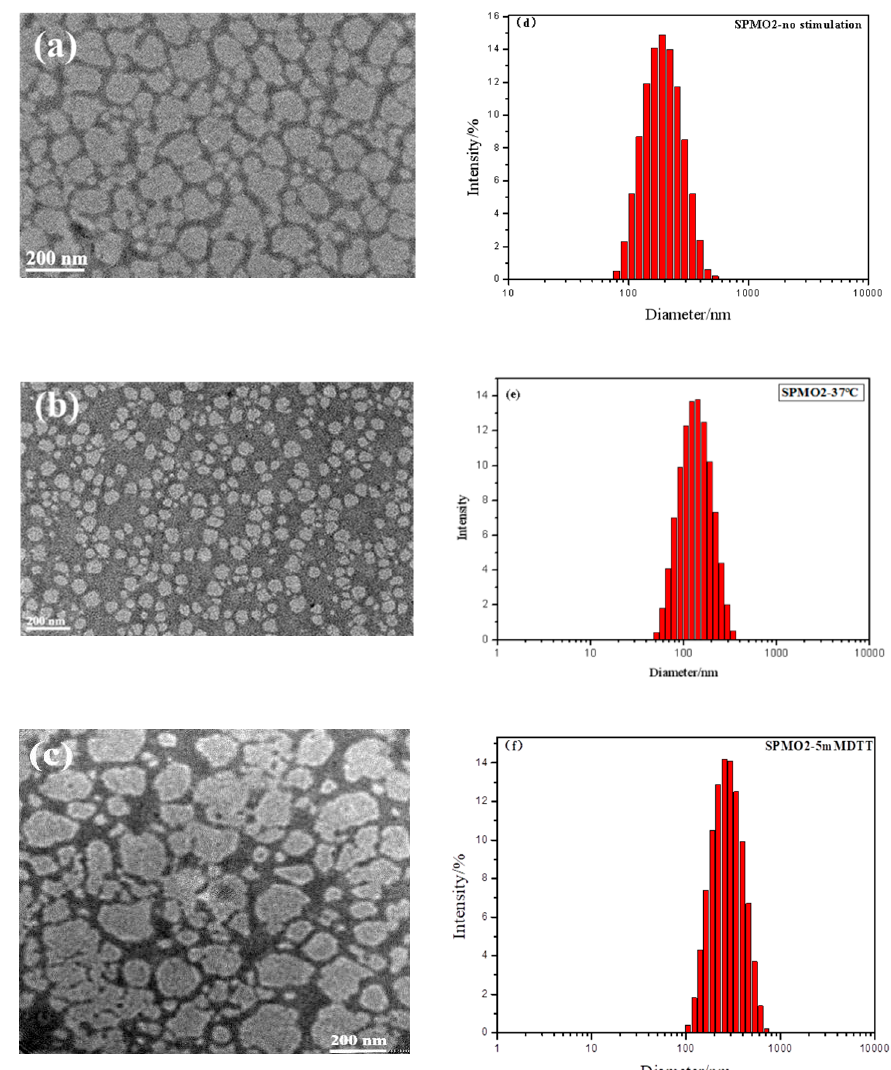
Figure 8. ( a ) Transmission electron microscope (TEM) image and ( d ) size distribution profile of SPMO2 micelles under no stimulation. ( b ) TEM image and ( e ) size distribution profile of SPMO2 micelles under 37°C. ( c ) TEM image and ( f ) size distribution profile of SPMO2 micelles under 5 mM DTT for 24 h.